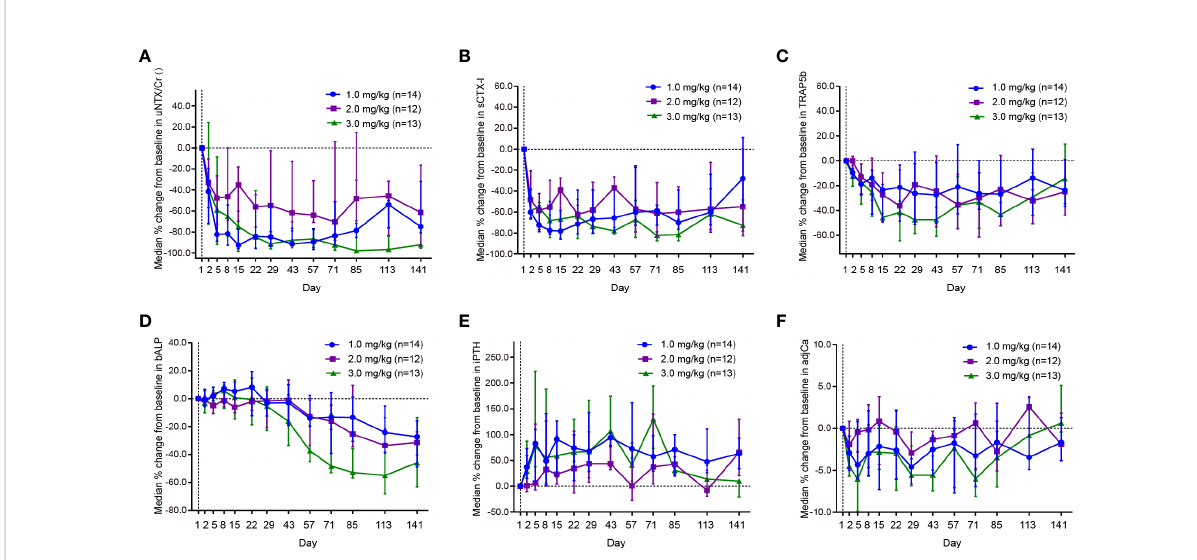
FIGURE 3 Effect of JMT103 on the concentration of (A) uNTx/Cr; (B) sCTx-I; (C) TRAP5b; (D) bALP; (E) iPTH; (F) adjCa. uNTx, urinary N-telopeptide; Cr, urinary creatinine; sCTx-I, serum C-telopept. TRAP5b, tartrate-resistant acid phosphatase 5b; bALP, bone alkaline phosphatase; iPTH, intact parathyroid hormone; adjCa, serum albumin-adjusted serum